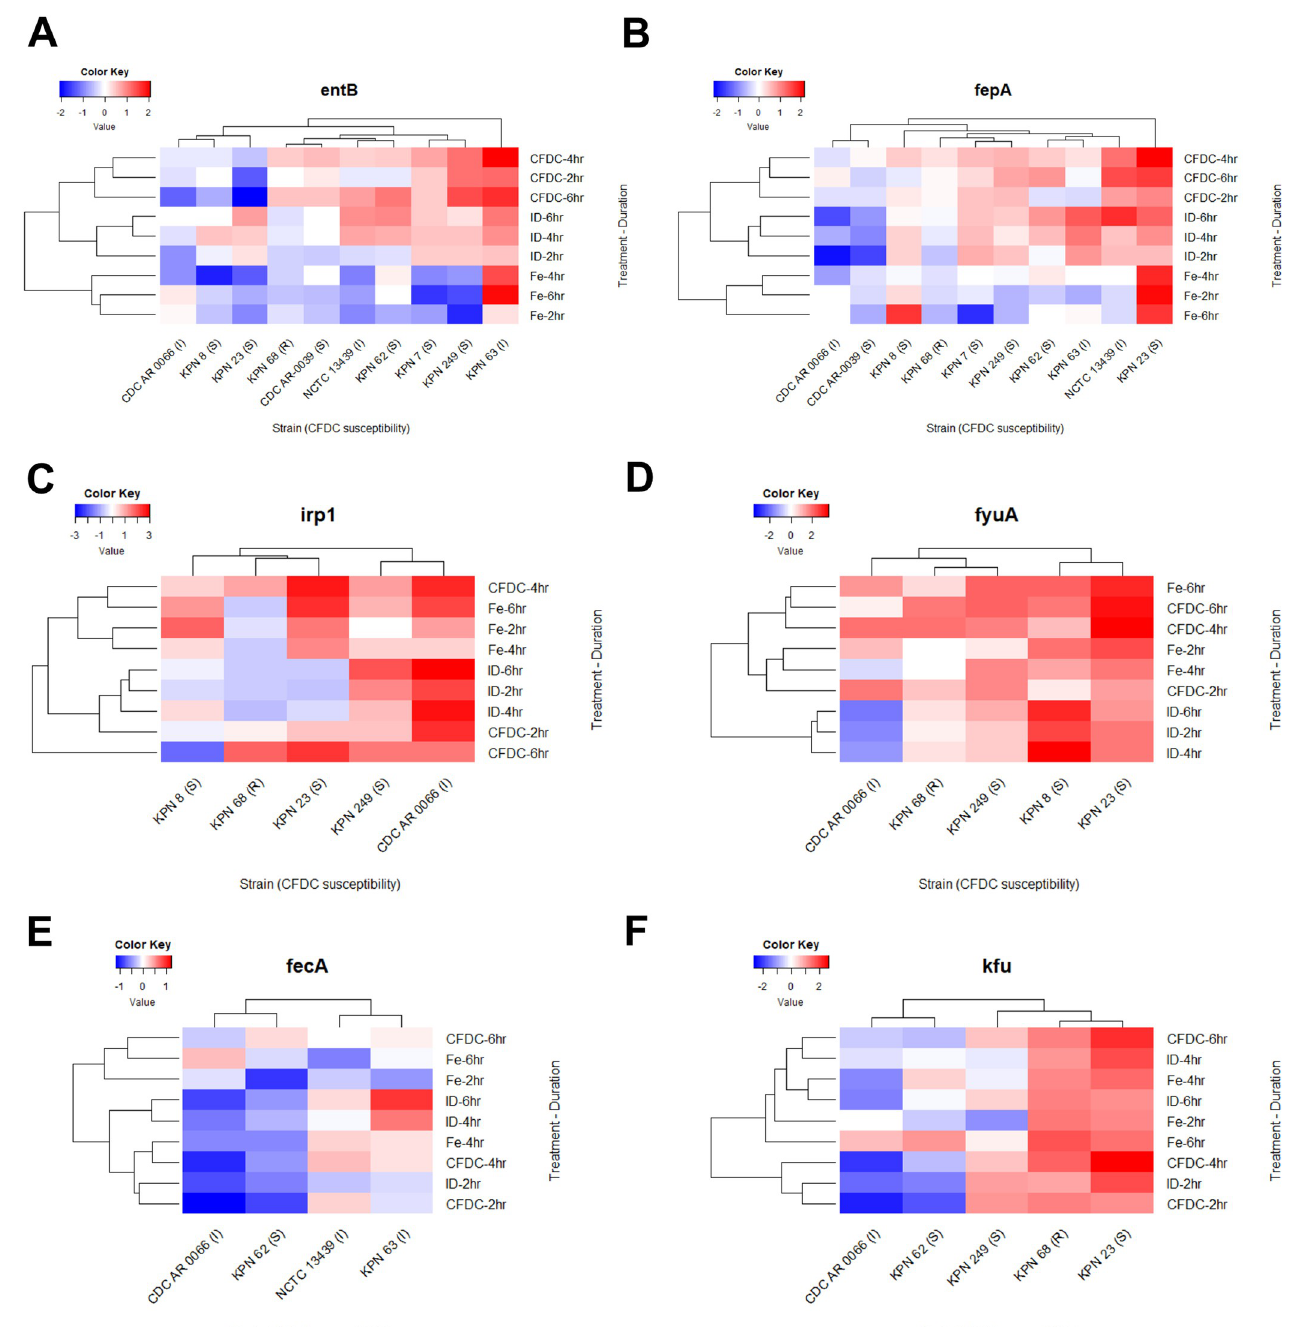
Fig 6. Heatmaps showing the expression of the genes encoding siderophores, their receptors with other iron transport receptors. Expression of siderophore genes including entB and irp1 (A and C), siderophore receptors fepA and fyuA (B and D), fecA ferric iron transport receptor (E) and kfu iron uptake receptor (F) are shown. Fold changes of expression were calculated for strains grown in different media by comparing the expression of each gene to the baseline expression for the same gene at 0 hr.